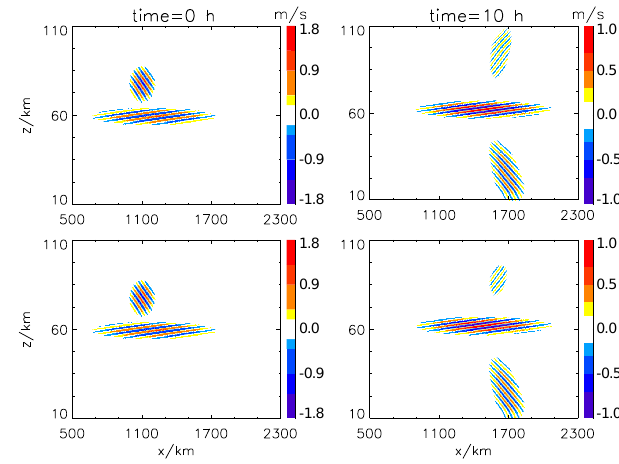
Fig. 8. Wave excitations in cases 3 (top) and 4 (bottom) by using square root density-weighted horizontal velocity